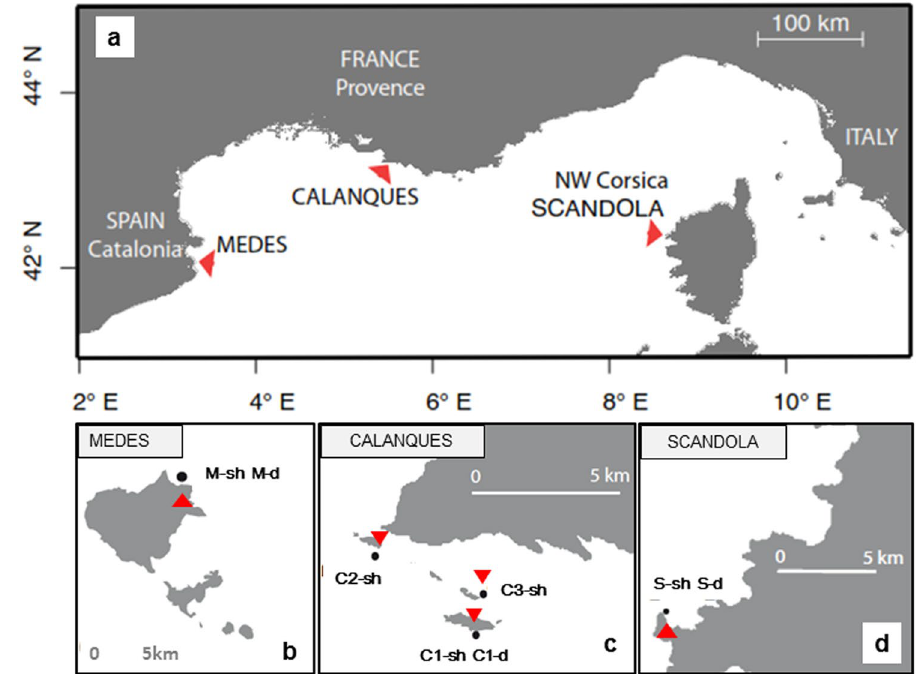
Figure 1. The study localities. The northwestern Mediterranean region with study localities ( a ). The study localities Medes ( b ), Calanques ( c ) and Scandola ( d ) and their populations: Medes shallow (M-sh, b) and Medes deep (M-d, b), Calanques 1, 2 and 3 shallow (C1-sh, C2-sh, C3-sh, c) and Calanques 1 deep (C1-d, c), Scandola shallow (S-sh, d) and Scandola deep (S-d, d). Figure 1a–d were performed with marmap R package 88 (https://